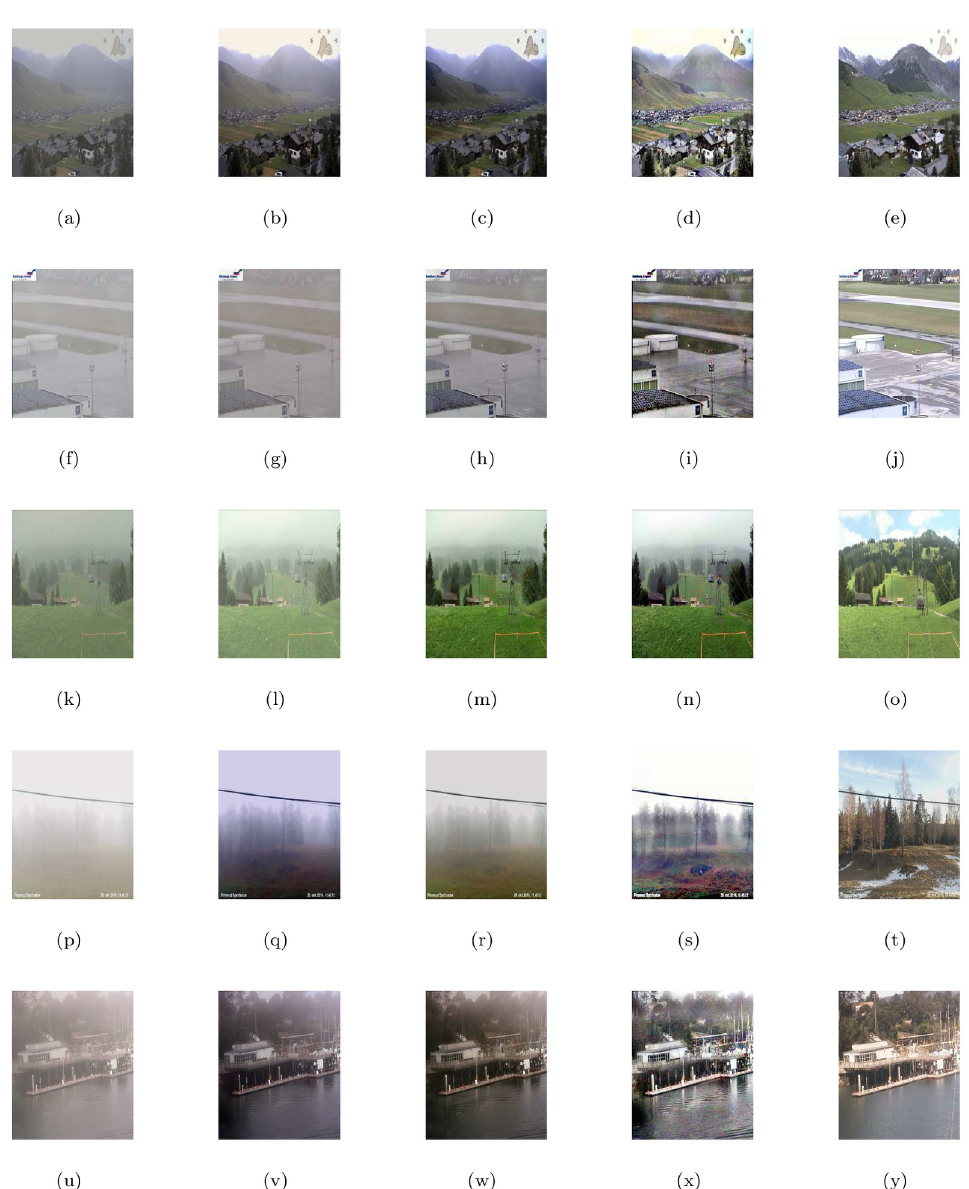
Fig 17. De-hazing performance of the proposed de-hazing model in comparison with the existing models. From L to R, columns represent the given images, Cho et al. [9] results, He et al. [4] results and proposed model results,